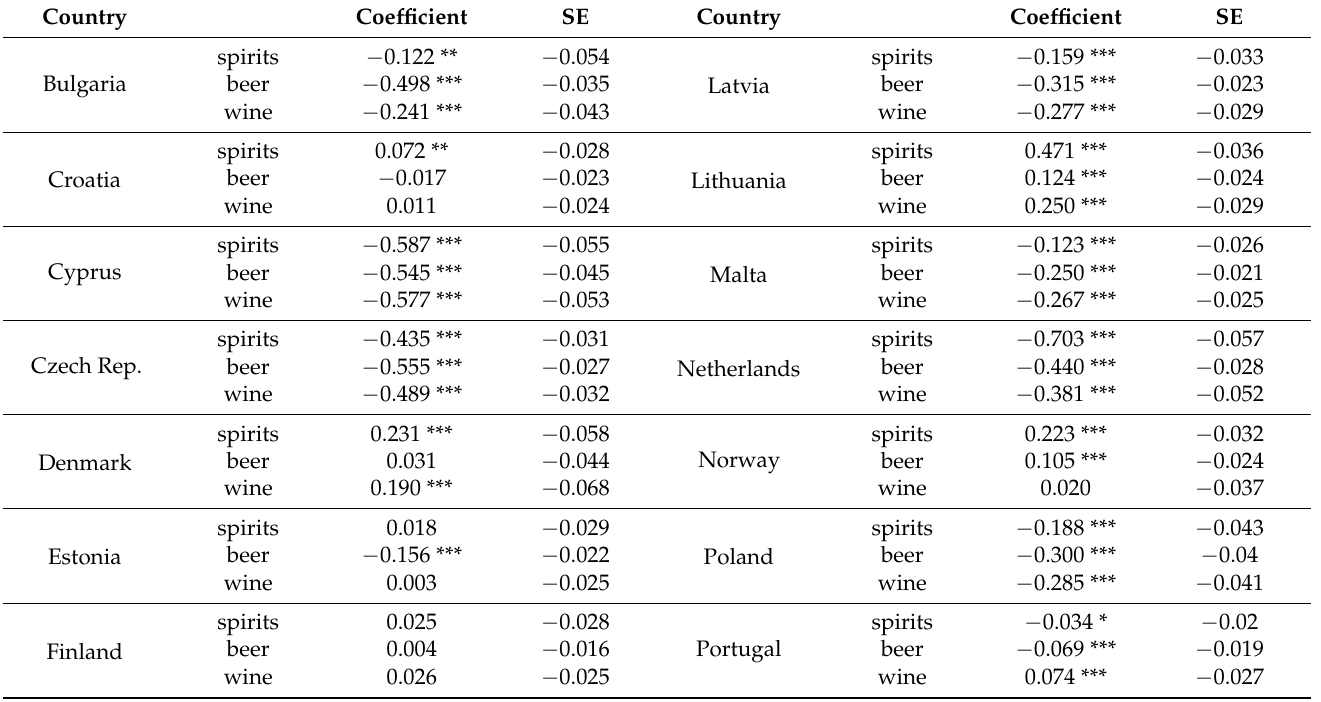
Table A4. Regression coefficients of time trends in beverage proportions with reference category cider/alcopops for